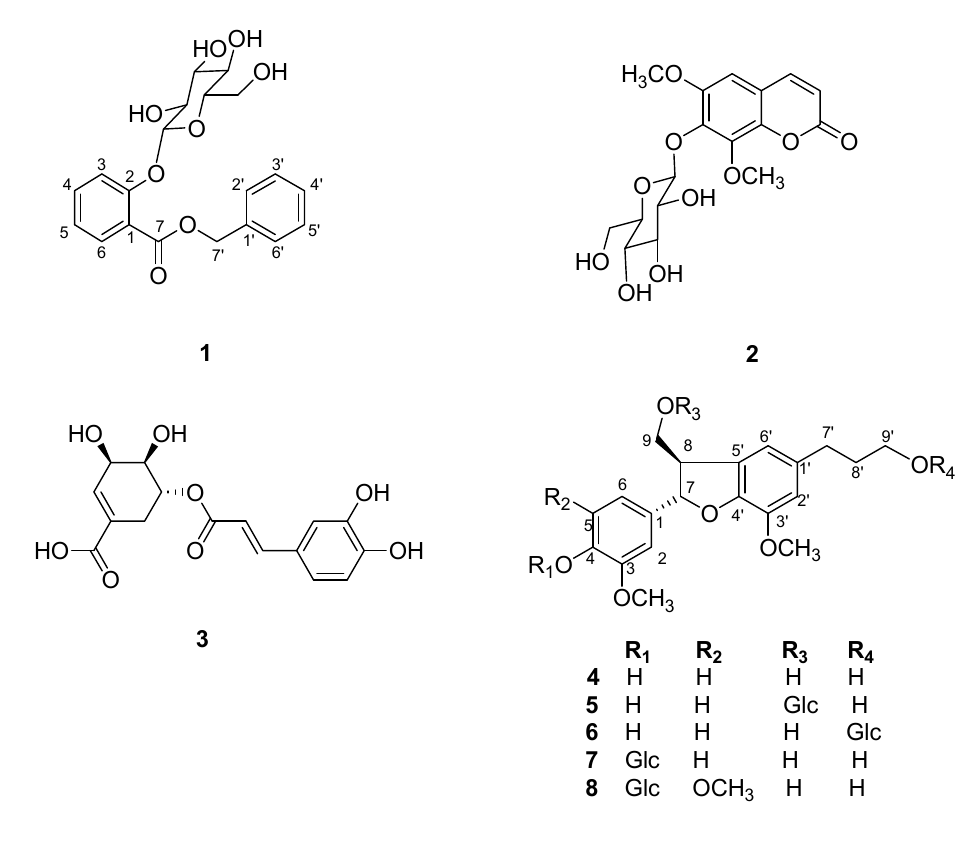
Figure 1. Structures of compounds 1 – 8